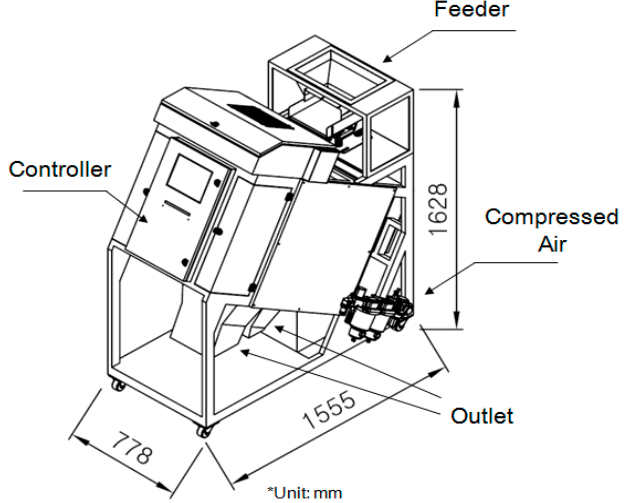
Figure 1. Schematic diagram of the optical sorter in this study.